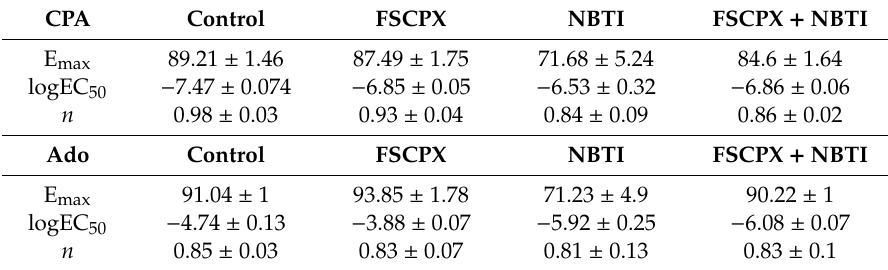
Table 1. The Hill parameters of the CPA and adenosine concentration-response (E / c) curves of Figure 1. CPA Control FSCPX NBTI FSCPX +